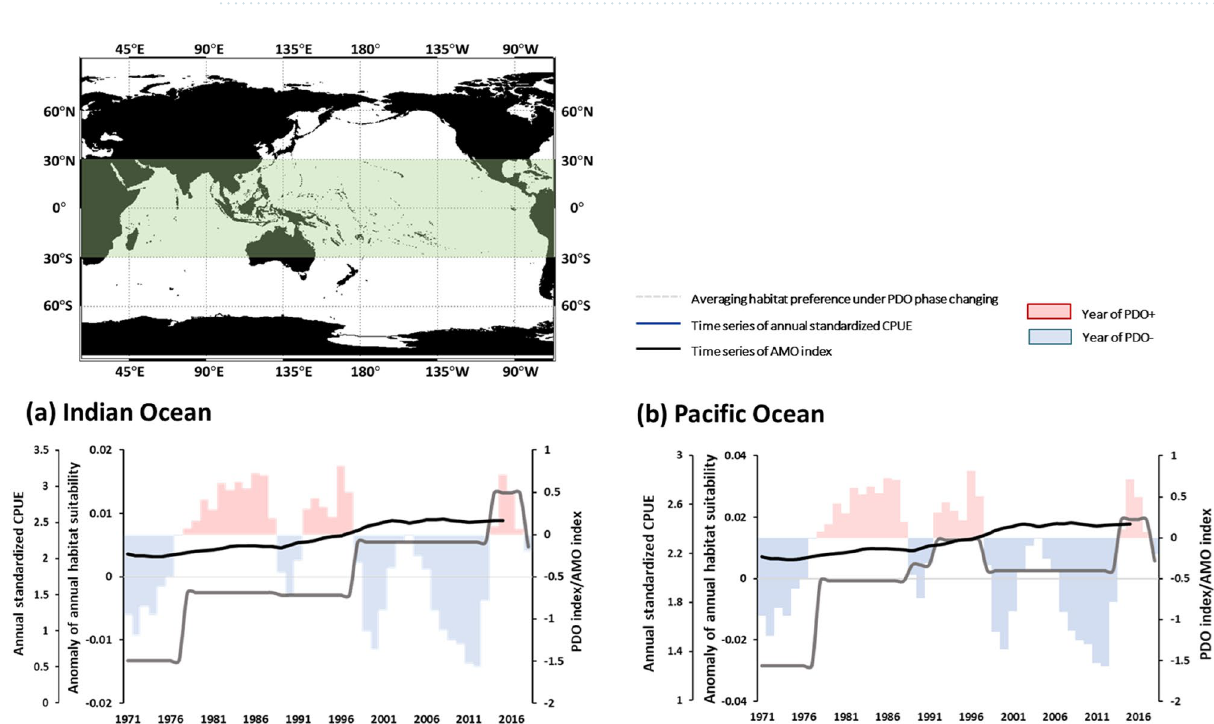
Figure 4. Average HSI anomalies of yellowfin tuna during AMO and PDO phase changes in designated